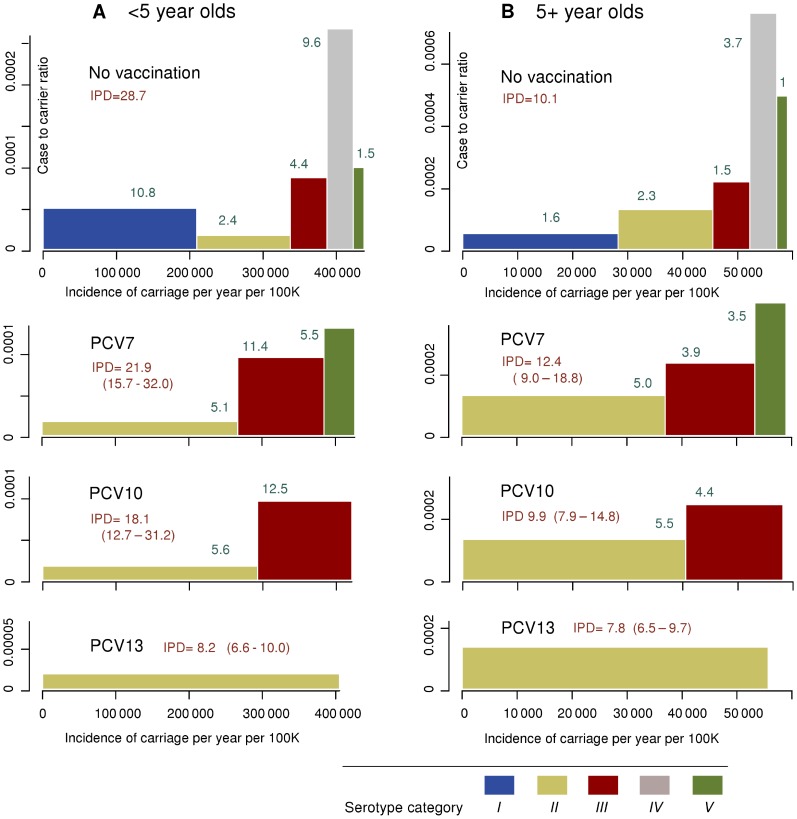
Incidence of carriage and case-to-carrier ratios by serotype category in two age classes in Finland.The stationary incidence of pneumococcal carriage (per year per 100,000 persons) is indicated on the horizontal axis by category, shown cumulatively. The serotype category-specific case-to-carrier ratios are shown on the vertical axis; note the different scales in the <5 and 5+ panels. The area of each rectangle represents the annual IPD incidence (per 100,000) in the respective serotype category. The upmost horizontal pair of panels shows the annual IPD incidence (per 100,000) before vaccination. The category-specific incidences of carriage (horizontal axis) correspond to the average pre-vaccination incidences. The other panels correspond to the projected IPD incidences after the onset of vaccination programme with PCV7, PCV10 and PCV13. The projected overall and serotype category-specific IPD incidences (indicated in green font) are obtained as averages from simulation runs based on the 50 most optimal parameter combinations. The post-vaccination panels show the average projected IPD incidence (area), the average case-to-carrier ratios (vertical axis) and the corresponding incidence of carriage (horizontal axis). The pairs of values in parentheses are the corresponding ranges of projected IPD incidences based on the 50 simulation runs.